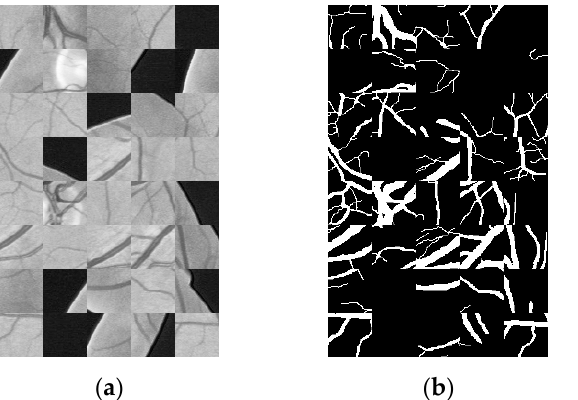
Figure 3. Example of local section ( a ) sample of local section ( b ) sample result of local section.